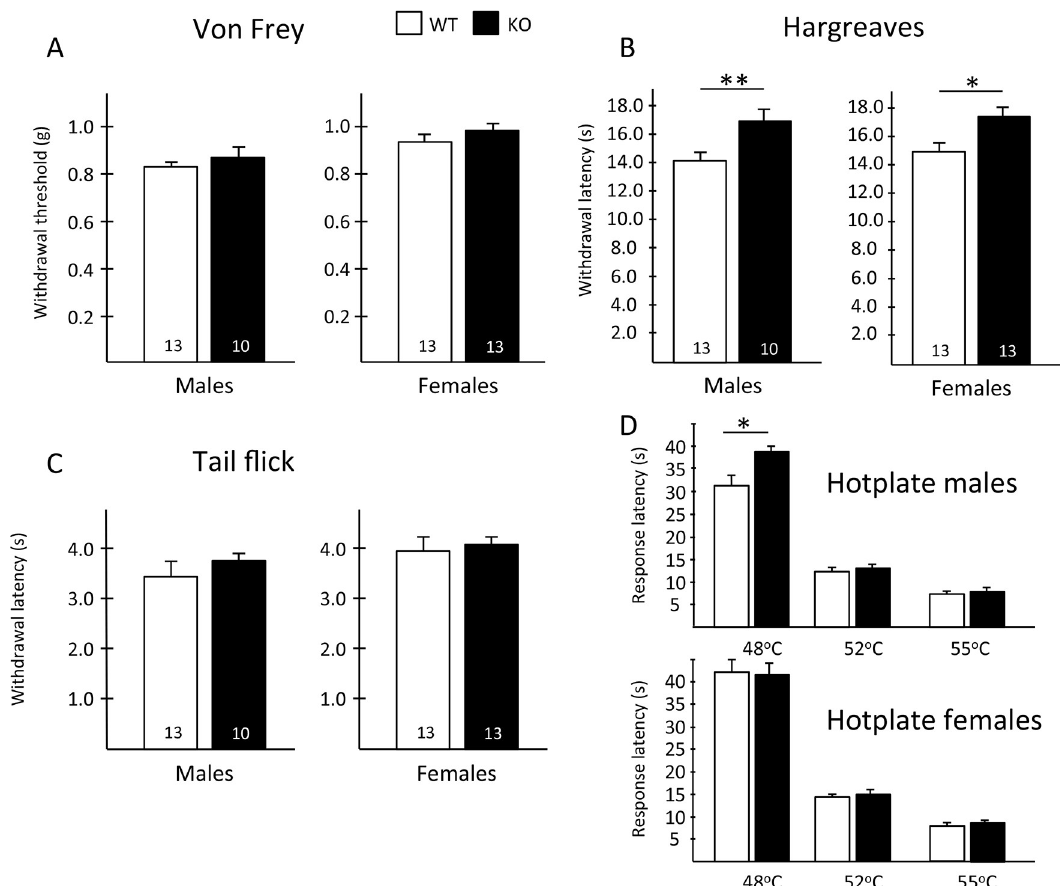
Fig 2. Hippocalcin-like 4 mutant mice have reduced heat, but normal mechanical pain responses. (A) Baseline mechanical thresholds of Hpcal4 mutant (KO, black bars) mice did not differ from na ï ve (WT, white bars) mice. (B) In contrast, both male and female Hpcal4 mutant mice exhibited higher paw withdrawal latencies in the Hargreaves test. (C) There is no behavioral differences in the tail immersion tests for either gender. (D) In the hotplate test male, but not female Hpcal4 mutant mice, exhibit higher response latencies, at 48˚C, but not at higher temperatures. Data are presented as mean ± SEM; Statistical significance was determined by Student’s t-test in A-C and 2-way ANOVA (D), � p < 0.05, �� p < 0.01.